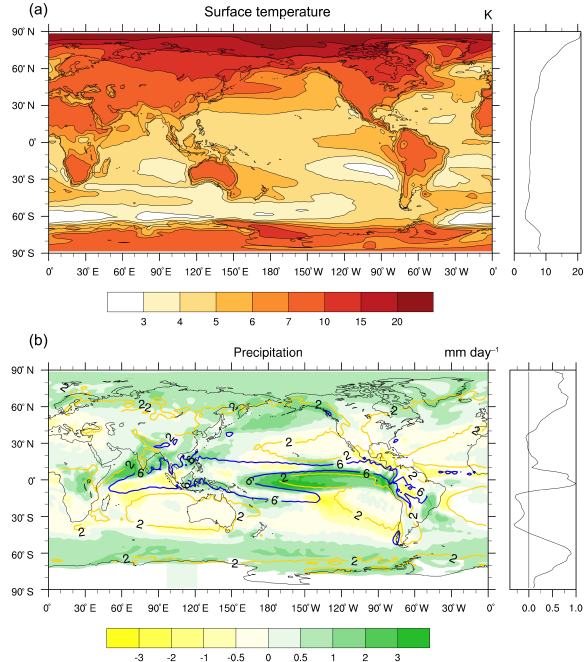
Figure 17. Changes in the surface temperature (a) and precipita- tion (b) derived from the last 30-year climatology in the 150-year abrupt4xCO2 experiments. The changes are with reference to the corresponding climatological mean fields from the PI experiment. The right panels show the corresponding zonal mean changes.